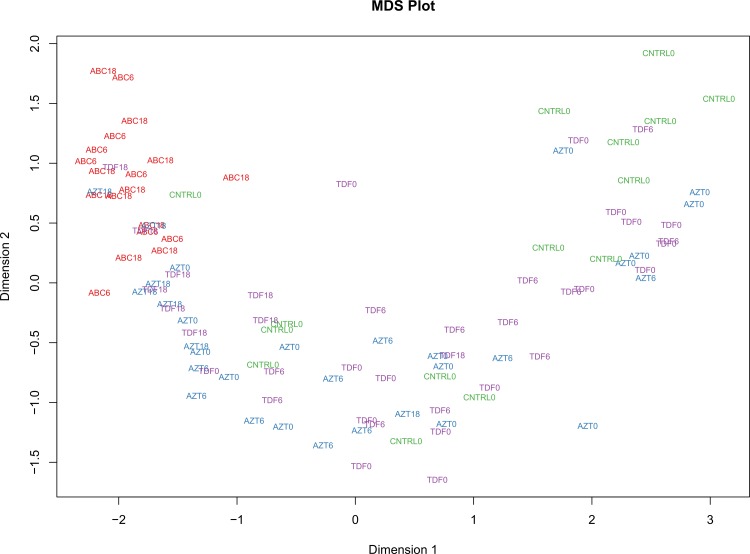
The multi-dimensional scaling plot (MDS) shows that by and large ABC 6 and ABC 18–24 samples are separated from other samples in the study.Distances in the plot represent root-mean-square deviation (Euclidean distance) for the top 500 genes that best distinguish those samples.